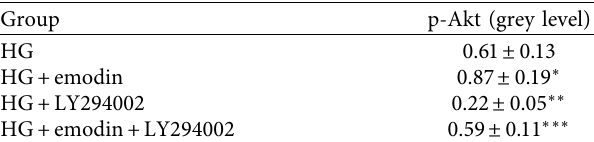
Table 3: Effect of emodin on p-Akt protein expression level